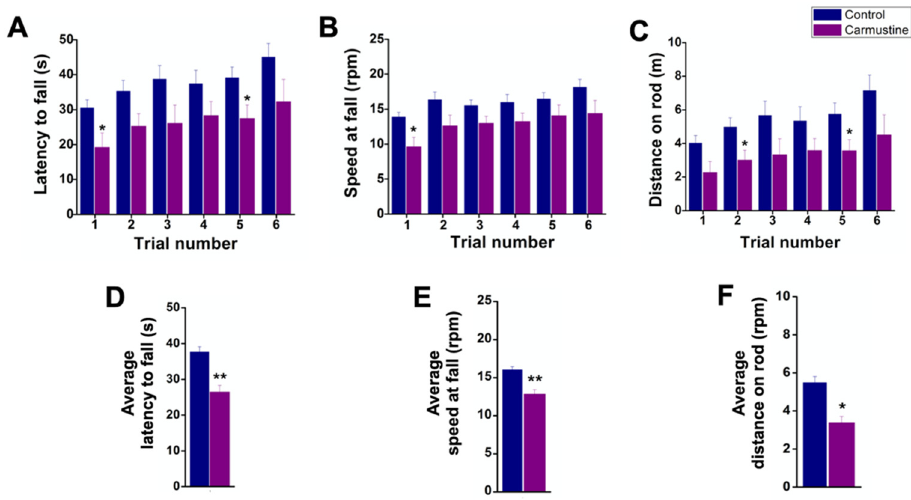
Figure 1. Deficiencies in motor coordination of carmustine-treated mice. Comparative analysis between control and carmustine-treated groups. ( A ). Mice treated with carmustine spent less time on an accelerating rotarod; this was significantly different in trials 1 and 5 ( p < 0.05). ( B ). The speed at which the carmustine-treated group fell was slower in the six trials, but statistically significant only in trial 1 ( p < 0.05). ( C ). The carmustine-treated group traveled a shorter distance throughout the test, but statistically significant in trials 2 and 5 ( p < 0.05). ( D ). The average latency to fall is shown for each group (Ctrl 37.64 ± 1.49 s, Carmustine 26.45 ± 1.86 s) **. ( E ). The average speed at fall is shown for each group (Ctrl 16.03 ± 0.42 rpm, Carmustine 12.83 ± 0.59 rpm) **. ( F ) The average distance traveled is shown for each group (Ctrl 5.48 ± 0.31 m, Carmustine 3.26 ± 0.30 m) **. (Control n = 6, Carmustine n = 6). Data are represented as the mean ± the standard error of the mean. * indicates significant difference ( p < 0.05) and ** indicates significant difference ( p < 0.001) both compared to the control group.